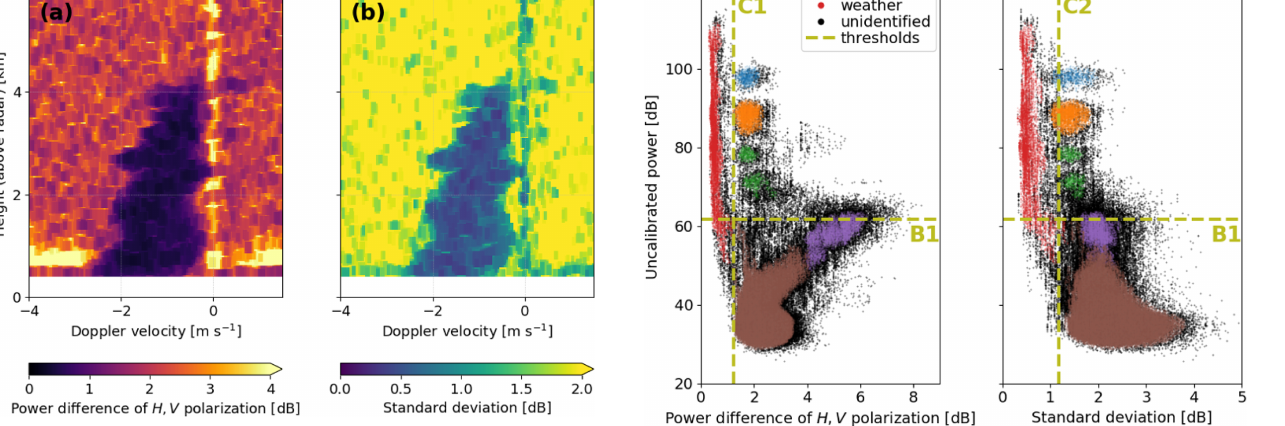
Figure 4. HDBSCAN cluster analysis of the Doppler spectra sum- marized in Fig. 1 and the two polarimetric parameters shown in Fig. 3. Colored regions indicate the clusters identified by HDB- SCAN, and black dots mark data points that could not be assigned confidently by HDBSCAN to any of the clusters. Dashed olive lines give automatically determined thresholds (C1, C2, B1 as defined in the text), separating the core of the weather signal (red dots) from the other clusters that represent different non-meteorological con- tributions to the overall radar